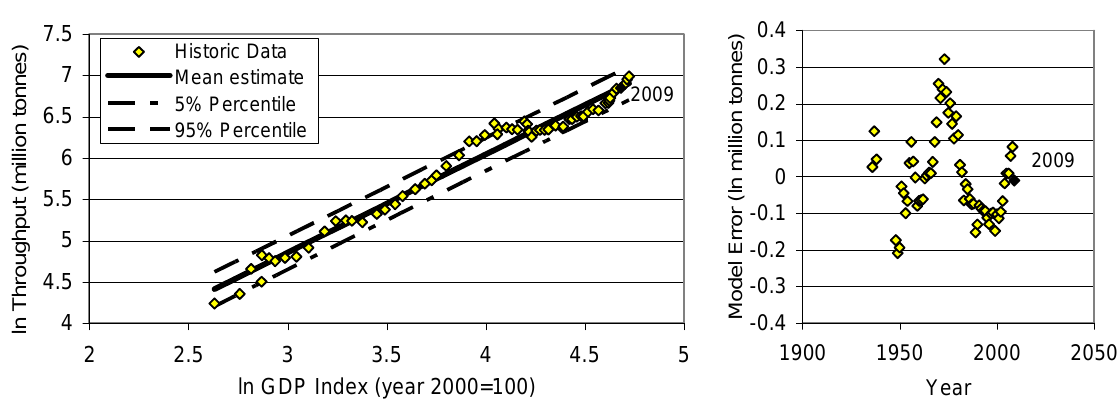
Figure 4. Linear Regression between natural logarithm of GDP and Port Throughput Levels Historic Relation Differences GDP and Port Throughput